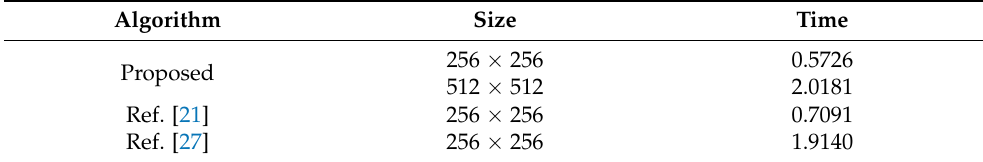
Table 5. Comparison of encryption